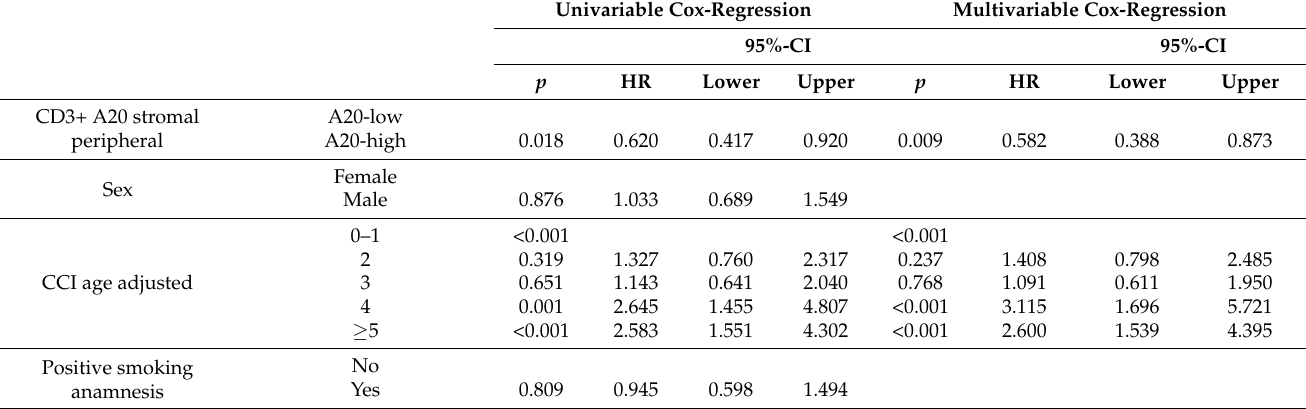
Table 2. Results from univariable and multivariable Cox-regression analyses for overall survival in patients according to high and low A20 expression, respectively (cut-off: 2.5 (median value)) within stromal CD3+ T cells in the peripheral tumor area. Multivariable analysis adjusted for age-adjusted Charlson comorbidity score, UICC stage, lymph vessel and blood vessel invasion, which proved to have p < 0.100 in univariable analysis. Tumor size, cervical node status and extranodal spread were dismissed in favor of UICC stage.